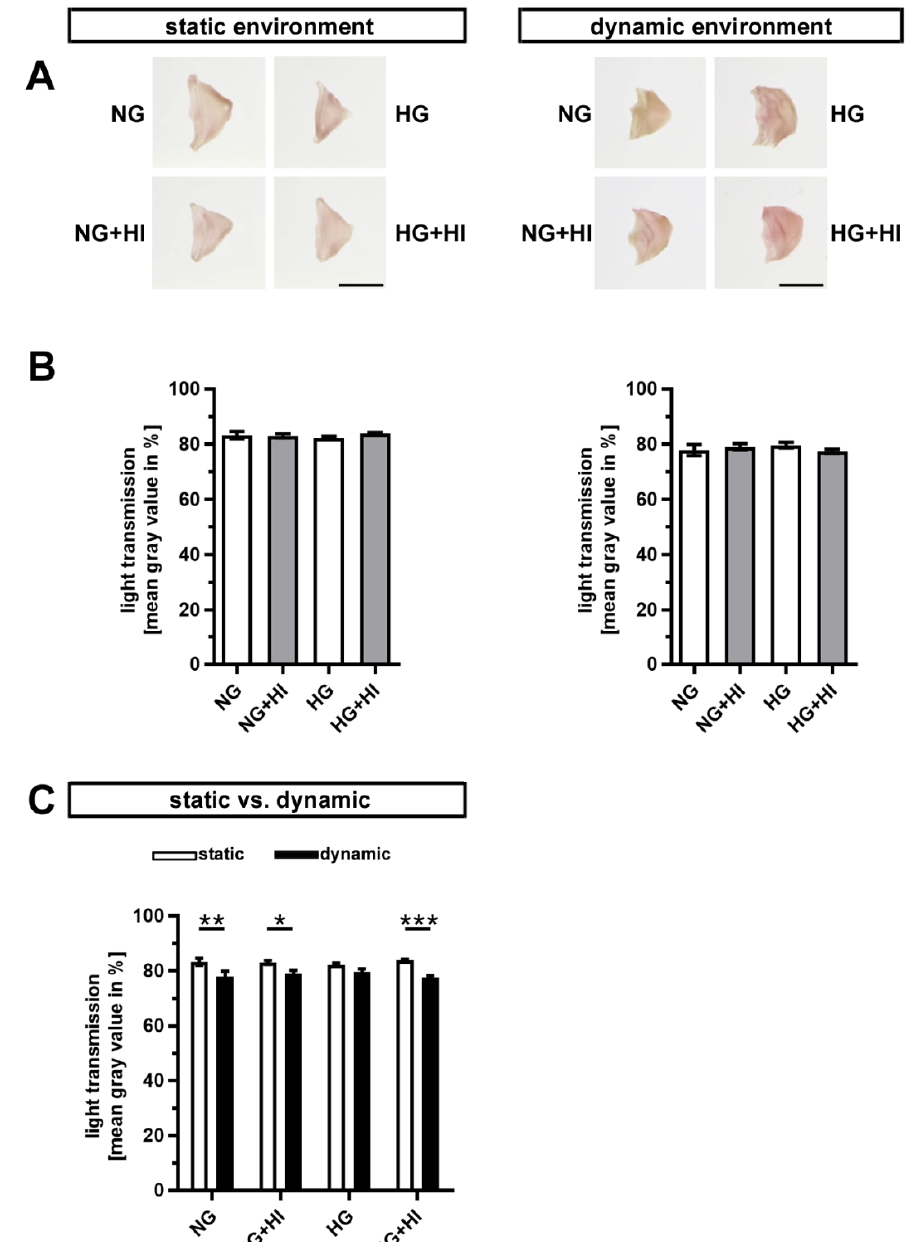
Figure 3. Density of AV tissue. ( A ) Macroscopic view of AV leaflets on a light pad after cultivation in a static (left) or dynamic flow environment (right). Bars: 1 cm. ( B ) Treatment of AV leaflets with chronic HI, HG or the combination of both had no impact on density of the tissue neither under static conditions (left) nor in an environment with dynamic flow (right). n = 5–6. ( C ) AV leaflets cultivated under dynamic flow conditions revealed a reduced light transmission and, with this, a higher density in comparison to statically cultivated AV tissue of the same treatment group. The calculated light transmission expressed as mean gray values inversely correlates with the level of tissue density in the sense that more dense tissue results in lesser light transmission and vice versa. n = 5–6; *: p < 0.05; **: p < 0.01; ***: p < 0.001; NG: normoglycemia; HI: hyperinsulinemia; HG: hyperglycemia.